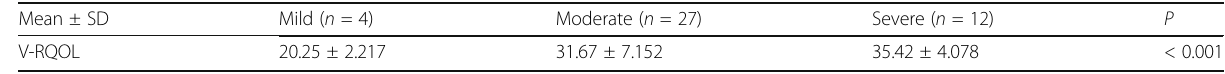
Table 7 Relation of total V-RQOL score of the dysphonic group to perceptual analysis of dysphonia grade